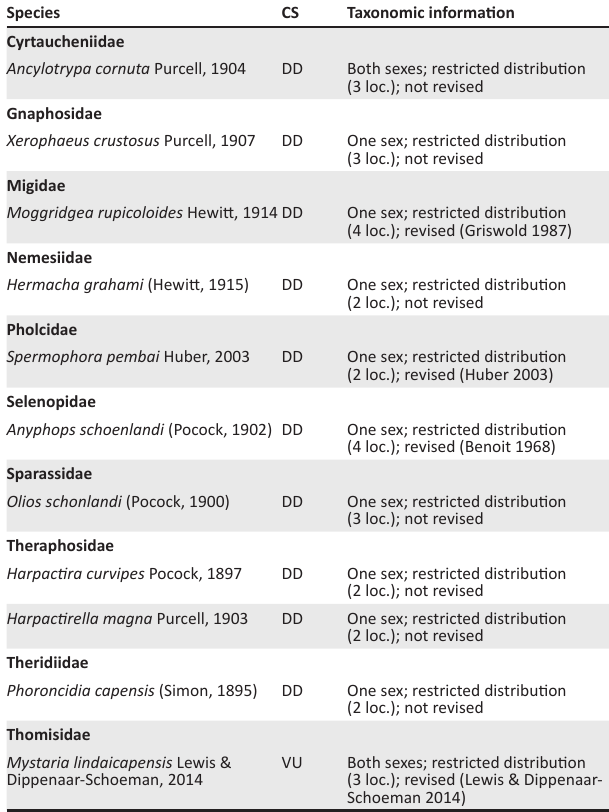
TABLE 2: Conservation status and endemicity of the spider species sampled at the Addo Elephant National Park. Distribution